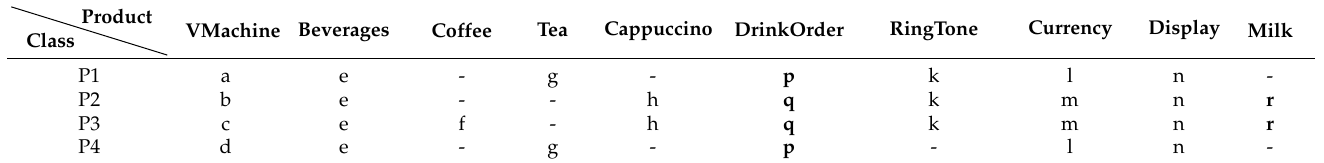
Table 12. The checksum matrix for SPL V2 . Checksum values changed in SPL V1 are presented as bold type.